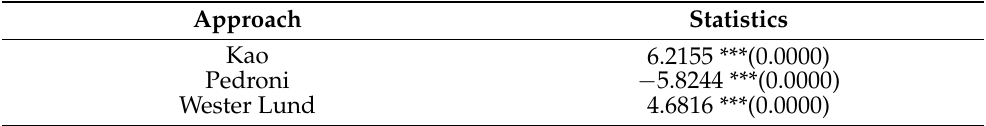
Table 4. Results of cointegration